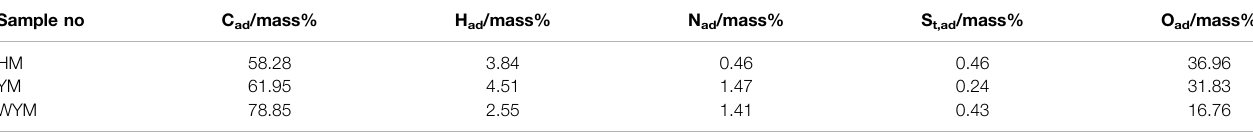
TABLE 2 | Ultimate analysis data of the coal samples.